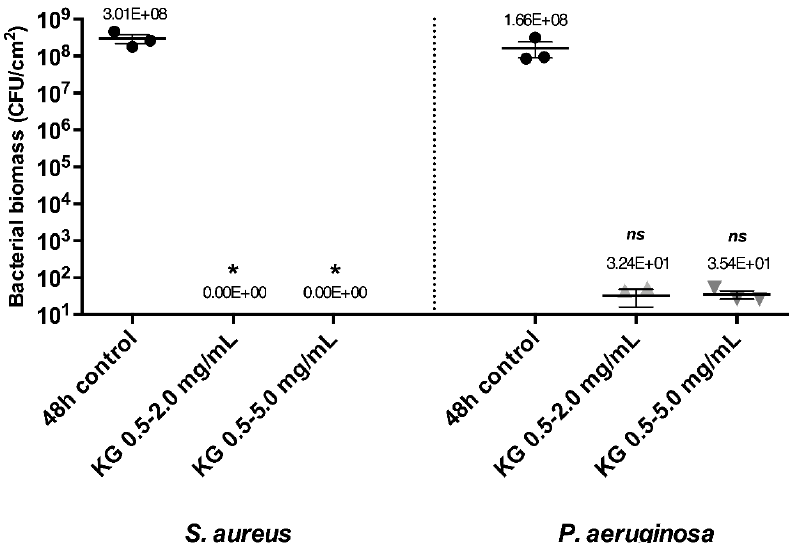
Figure 3. Bacterial biomass of S. aureus or P. aeruginosa mono-species mature biofilms after 24 h contact at 37 ◦ C with solutions of the KG combination at concentrations indicated. Error bars represent the standard error of the mean for at least three replicates. Statistically significant differences with 48 h control are marked with asterisks: * p ≤ 0.05, (ns — non-significant). A combination with lower concentrations of active molecules (KG 0.5 – 2.0 mg/mL)